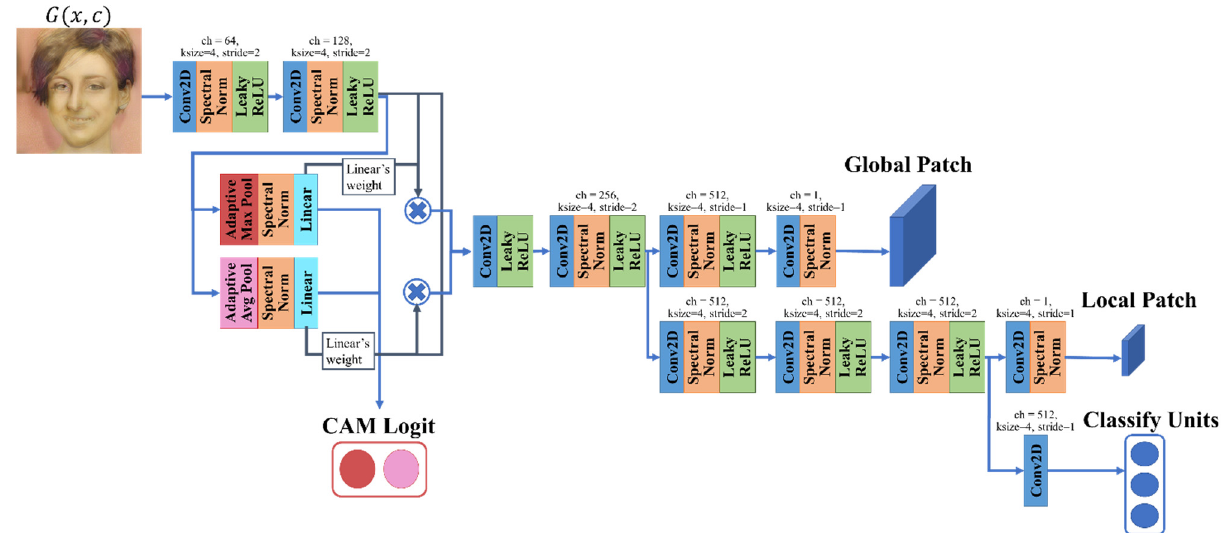
Figure 2. Overview of the discriminator in the Multi-CartoonGAN.